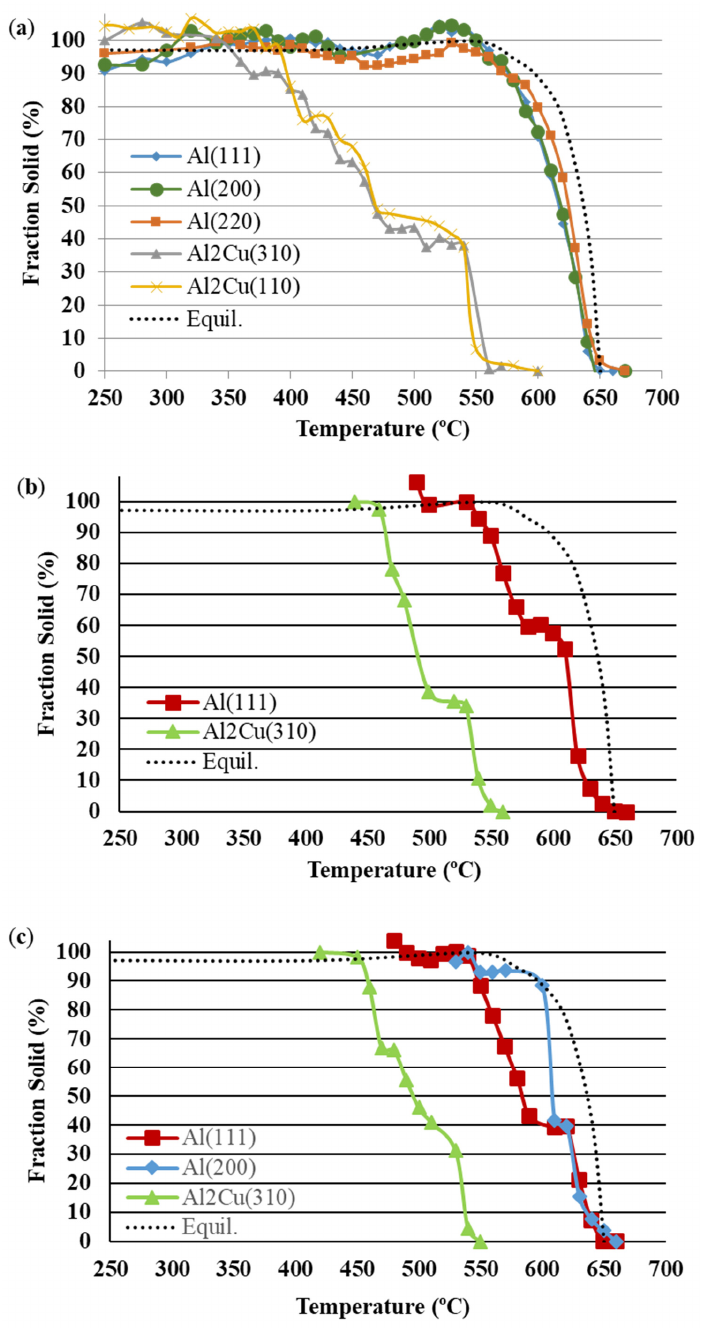
Figure 7. Fraction solid (%) versus temperature of ( a ) α -Al and Al 2 Cu for Al-Cu, ( b ) α -Al for Al-Cu-02Ti, and ( c ) α -Al and Al 2 Cu for